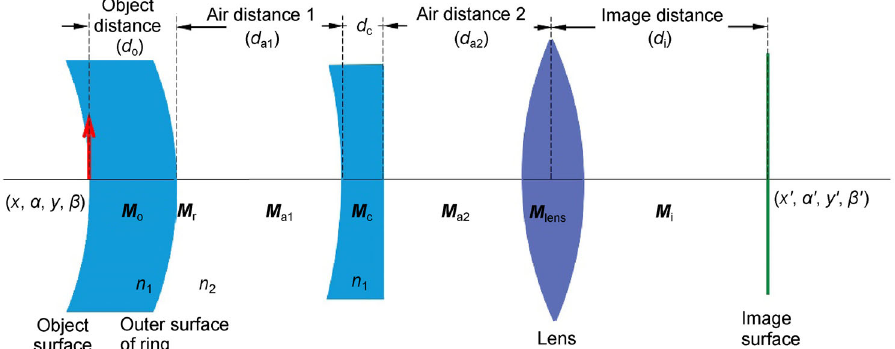
Fig. 6 Corrected optical